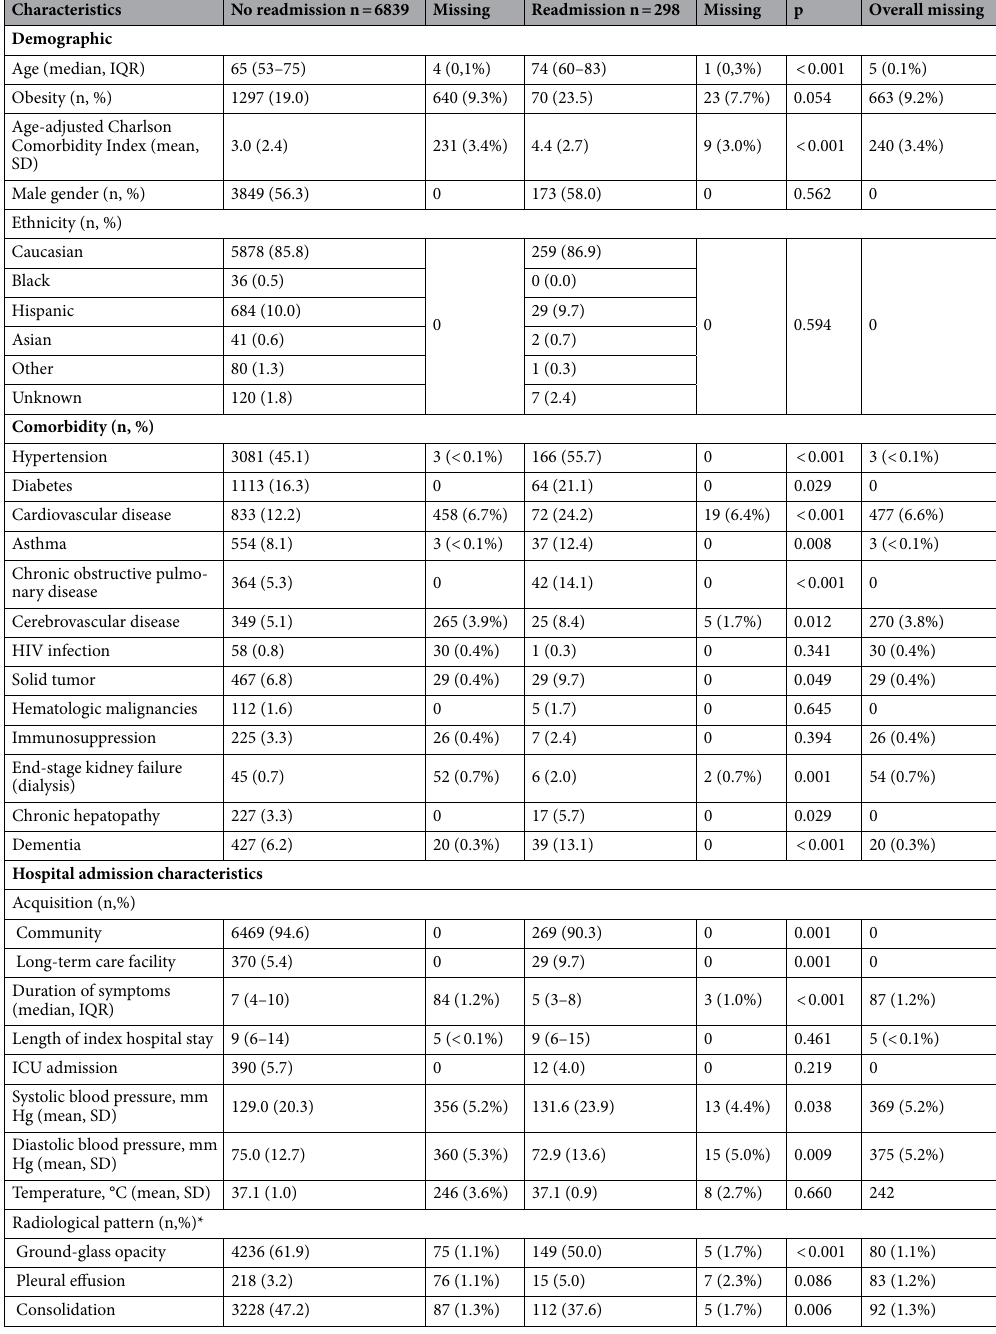
Table 1. Clinical characteristics of patients with COVID-19 according to hospital readmission. *A patient could have several radiological